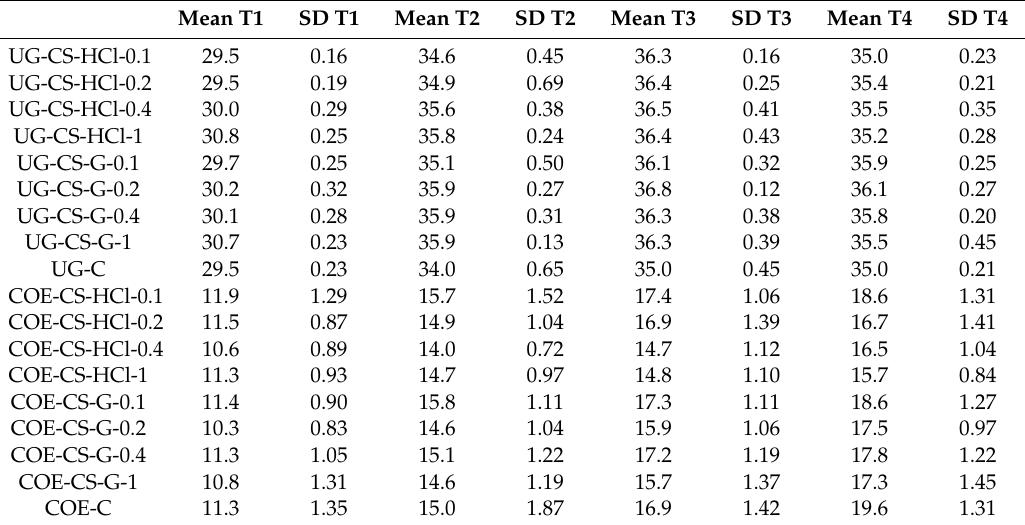
Table A2. Mean values and standard deviation (SD) for Shore A hardness.